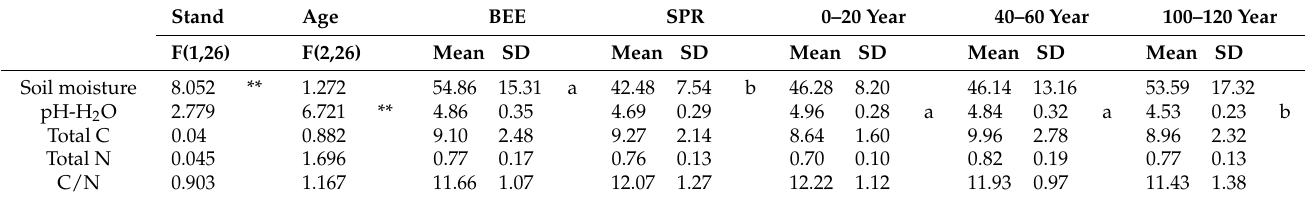
Results from main effect ANOVA (F and p -value with significance at p < 0.01(**) for both factors: stand and age). Significant differences ( p < 0.05) in mean values between age classes are indicated by different lowercase letters within a row (the Fisher LSD post hoc test). Significant differences between stands are marked.